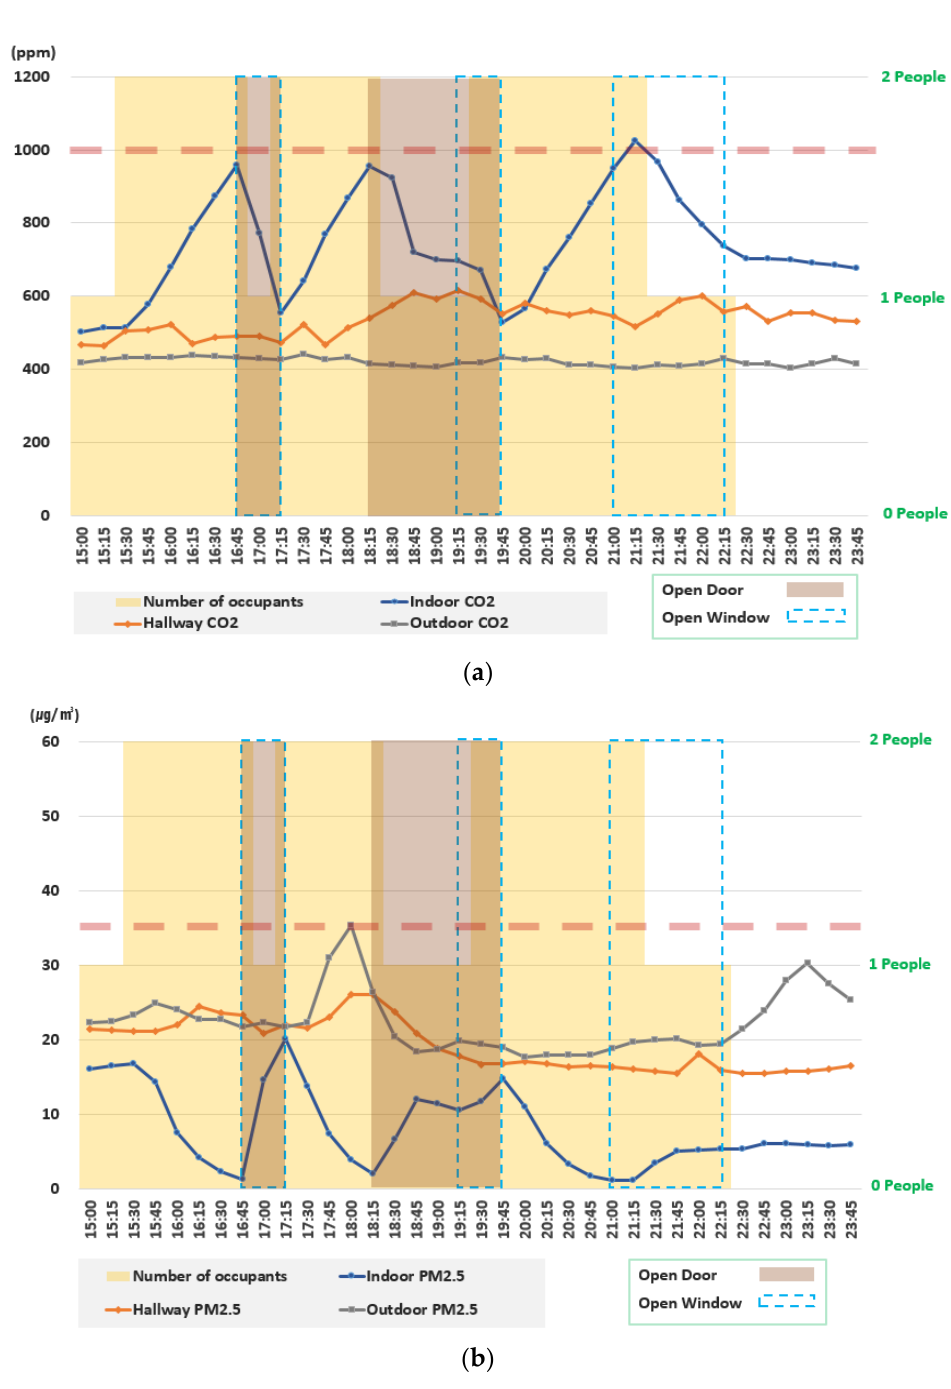
Figure 8. Indoor air quality measurement with various conditions on 22 April 2021, in a one-person office: ( a ) CO 2 concentration and ( b ) PM 2.5 concentration. office: ( a ) CO 2 concentration and ( b ) PM 2.5